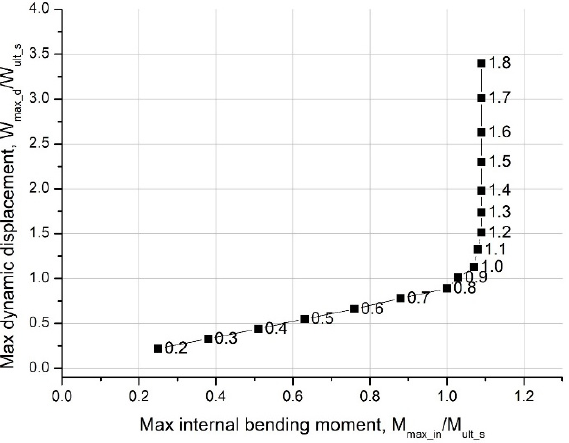
Figure 12. Internal bending moment and vertical displacement for mid-span box girder M2 at load duration time T d = 0.01 s (Data label denotes M d /M ult_s ).